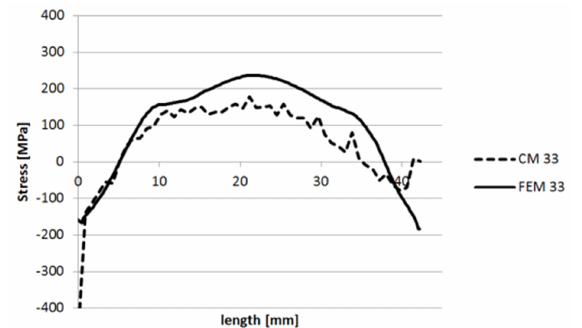
Figure 44. Stress levels in 33 direction along the CD line segment.